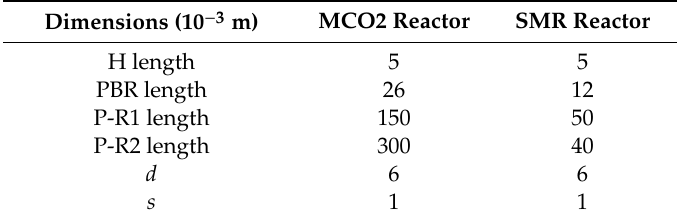
Table 1. Dimensions of the components of the tubular laboratory reactors used in MCO2 and SMR